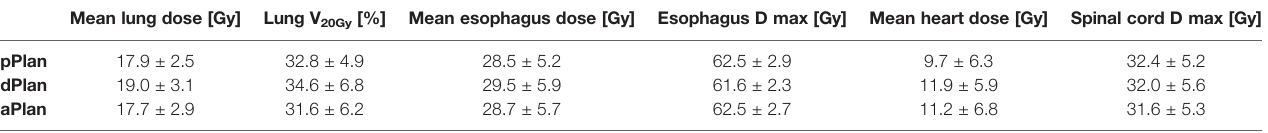
Gy, Gray; D max, maximum dose.